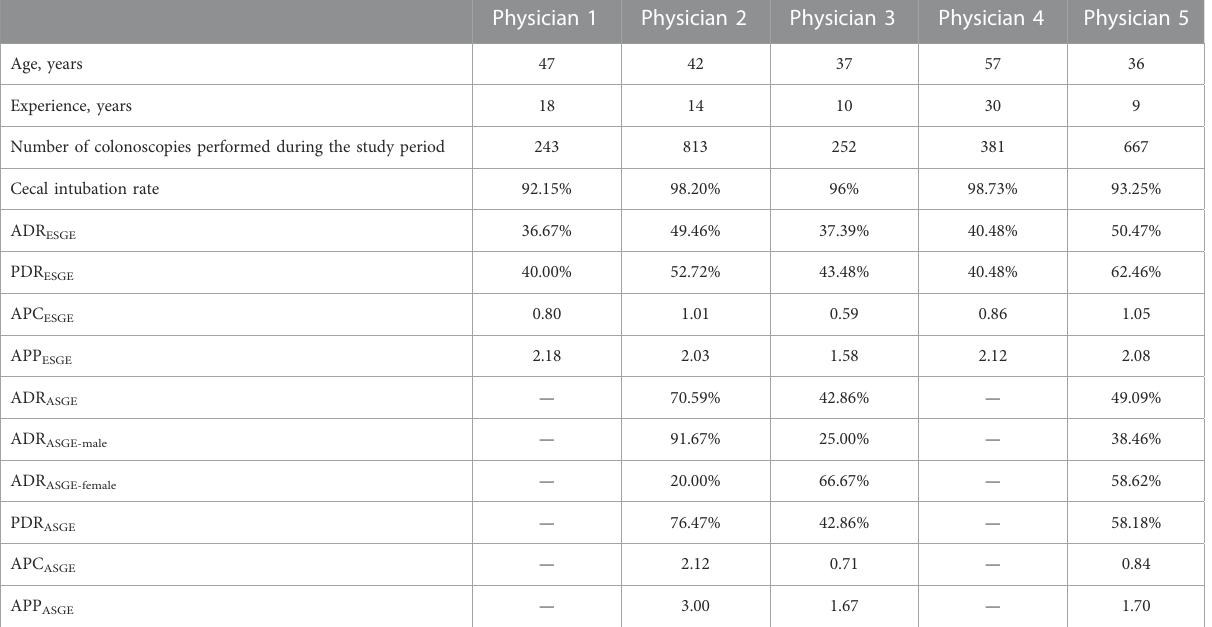
TABLE 3 Physician characteristics.